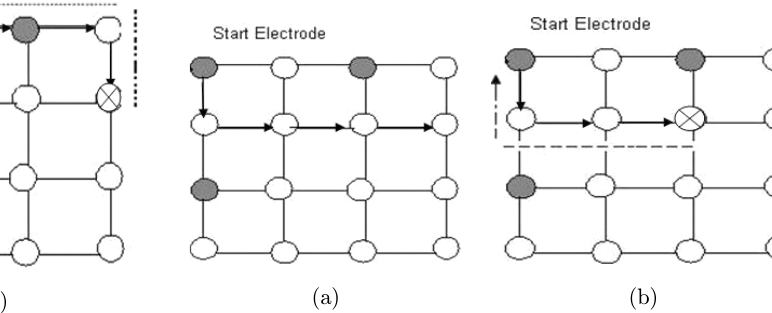
Fig. 7. Anticlockwise movement of droplet with a fault-free and a faulty loop and clockwise